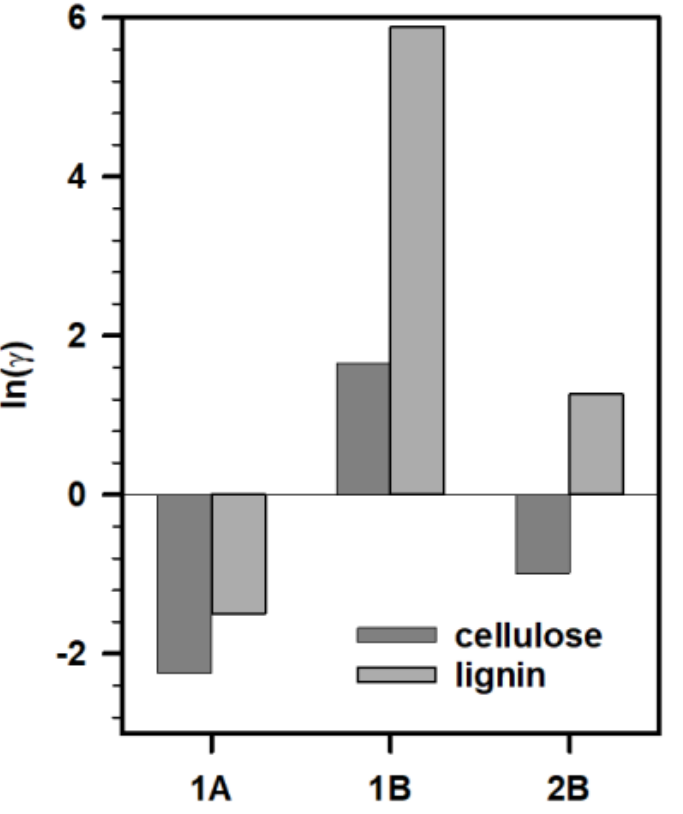
Figure 4. Activity coefficients of cellulose (dark gray) and lignin (gray) in IL 1A , 1B , and 2B .